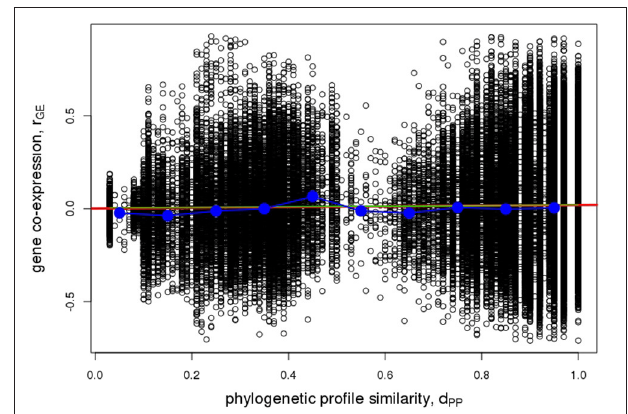
FIGURE 9 | Pairwise gene co-expression statistic. Association of pairwise phylogenetic profile similarity, d PP , and co-expression of Arabidopsis gene pairs as judged by their pairwise Pearson correlation coefficient, r GE . Raw pairwise data are plotted as open circles, the red line indicates the linear regression line ( r = 0.022, p = 2.9*10 − 11 ), the green line corresponds to a logistic fit virtually coinciding with the linear regression line, blue circles indicate median values of binned data (bin width = 0.1 d PP units) connected by straight lines for visual guidance.